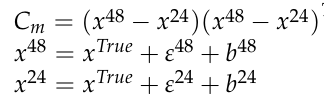
( c ) Figure 2. ( a ) Sea level height after data assimilation (calibration); ( b ) east–west component (u) of the SSC after data assimilation; ( c ) north–south component (v) of the SSC after data assimilation. ( a )